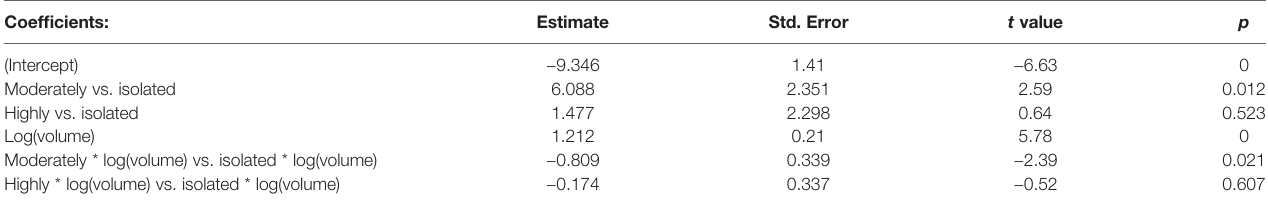
TABLE 5 | Simpli fi ed generalized linear model (ANCOVA) for total biomass of fauna in the rhodoliths (Isla del Coco, Costa Rica). Coef fi cients: